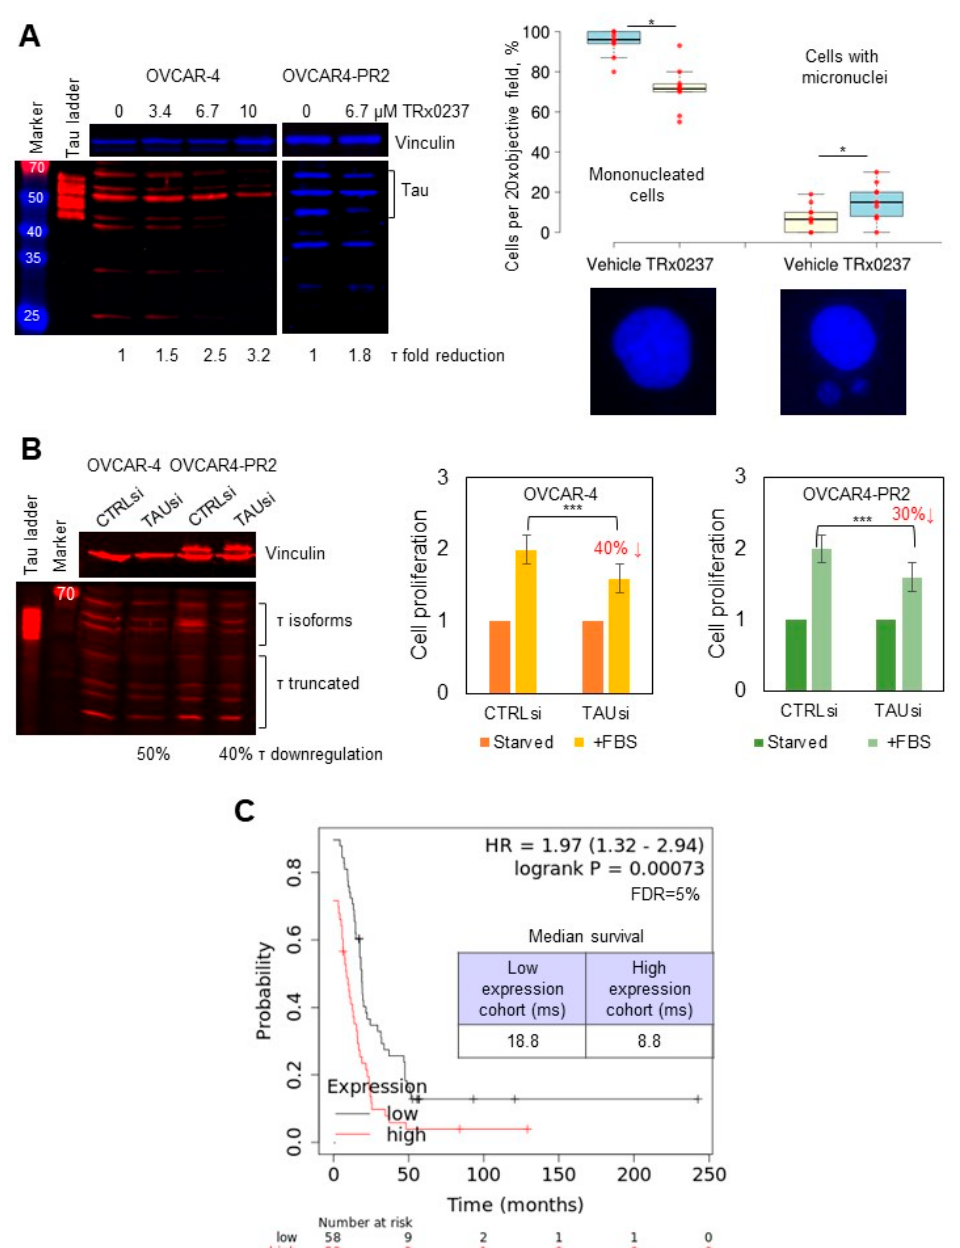
Figure 3. TRx0237 is cytotoxic to HGSOC cell lines, and low levels of tau reduce cell proliferation and increase patient survival. ( A ) Expression of tau was examined with Western blot using tau Ab-3 antibodies (1:1000 dilution); the parental and paclitaxel-resistant cells were treated with 0–13.4 µ M TRx023 and measured with digital densitometry. Vinculin was used as a loading control. Tau ladder consisting of 6 tau isoforms was used to determine positions of tau isoforms. OVCAR-4 were treated, or not, with 6.7 µ M TRx0237 for 24 h, fixed, and stained with DAPI. Cell nuclei were examined in 5 fields of view/slide in three independent experiments. The number of mononucleated cells and cells with micronuclei was quantified, averaged, derived as percent of total, and statistically analyzed using Mann–Whitney U test. Representative images are shown below the graph panel. ( B ) Expression of tau in OVCAR ‐ 4 and OVCAR4 ‐ PR2 was downregulated with tau ‐ specific pool of siR ‐ NAs for 3 days; on day 4 after transfection, cells were either starved or stimulated for proliferation with fetal bovine serum (FBS) for 24 h, followed by WST ‐ 1 assay. Tau downregulation was exam ‐ ined with Western blot. Vinculin: loading control. Positions of tau isoforms and truncated fragments are indicated. Tau ladder: 6 tau isoforms commonly found in the brain. * p < 0.05, *** p < 0.01, t ‐ test; average of 5 experiments. ( C ) Kaplan–Meier plotter database was used to analyze the progression ‐ free survival (PPS) as a function of tau expression in patients with serous ovarian cancer containing